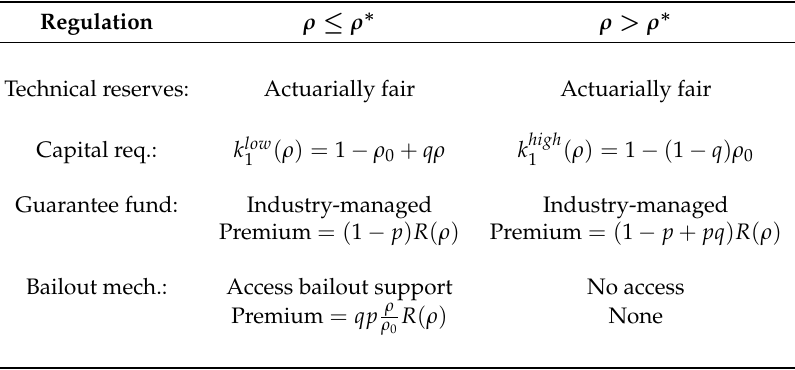
Table 1. Implementation of the optimal prudential